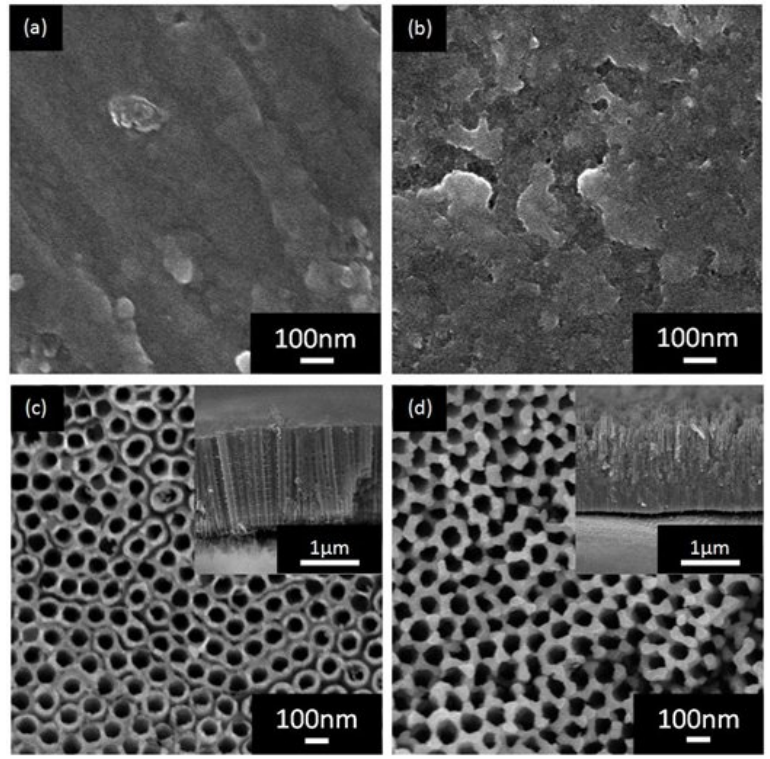
Figure 1. FESEM images of WO 3 -TiO 2 nanostructures obtained with varying fluoride ion content: ( a ) 0 wt %, ( b ) 0.1 wt %, ( c ) 0.3 wt %, and ( d ) 0.5 wt %. Insets are the side views of the samples. Table 1. Pore diameter, length, wall thickness, aspect ratio, and geometric surface area factor of WO 3 -TiO 2 nanotubes formed with varying fluoride ion content. NH F (wt%) 4